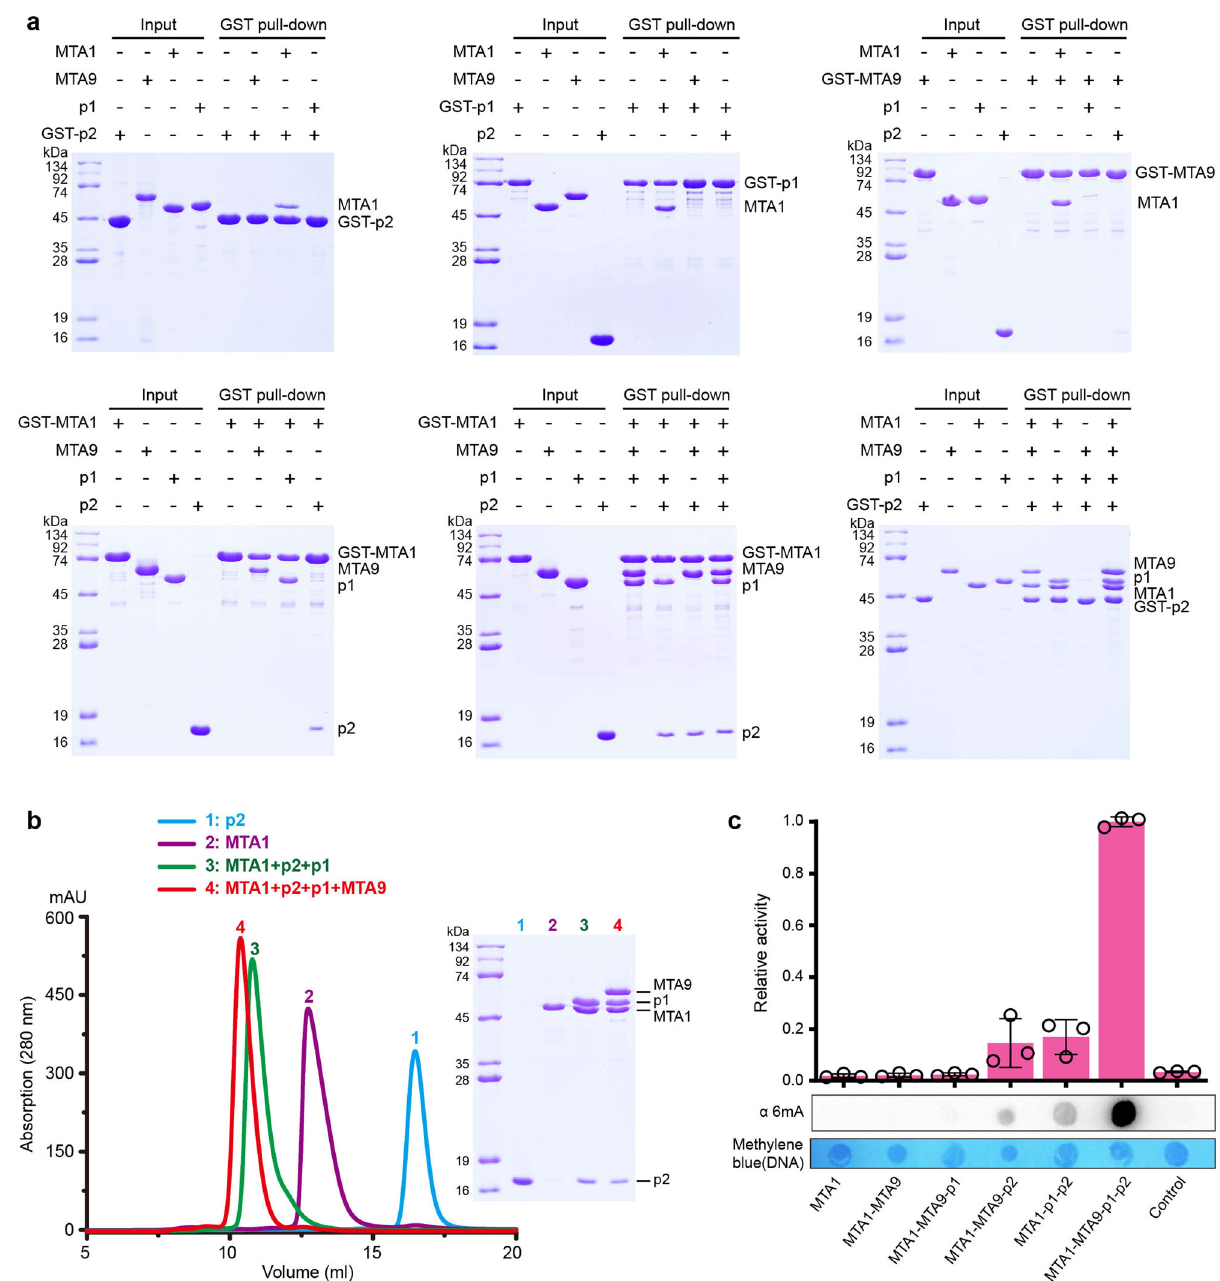
Fig. 1 Identi fi cation of the subunit assembly of the TthMTA1c complex. a GST pull-down assays for analyzing the direct interactions between MTA1, MTA9, p1 and p2. MTA1, MTA9, p1 and p2 were expressed in Escherichia coli and puri fi ed by Ni 2 + -agarose af fi nity column chromatography followed by size-exclusion chromatography. The SDS-PAGE gel was stained by Coomassie blue. b Gel fi ltration chromatography shows that MTA1 interacts with p1, p2 and MTA9. All samples were fractionated on a Superdex 200 increase 10/300, and the peak fractions were analyzed by SDS-PAGE. c Antibody-based methyltransferase activity of MTA1c complex and its subcomplexes on a 954-bp dsDNA. The dsDNA substrate was ampli fi ed by PCR from Tetrahymena thermophila strain SB210 genomic DNA. Data are shown as mean ± SD from n = 3 independent experiments; open circles indicate values for individual repeat measurements. Control, in the absence of MTA1c. Source data for ( a – c ) are provided in a Source Data fi